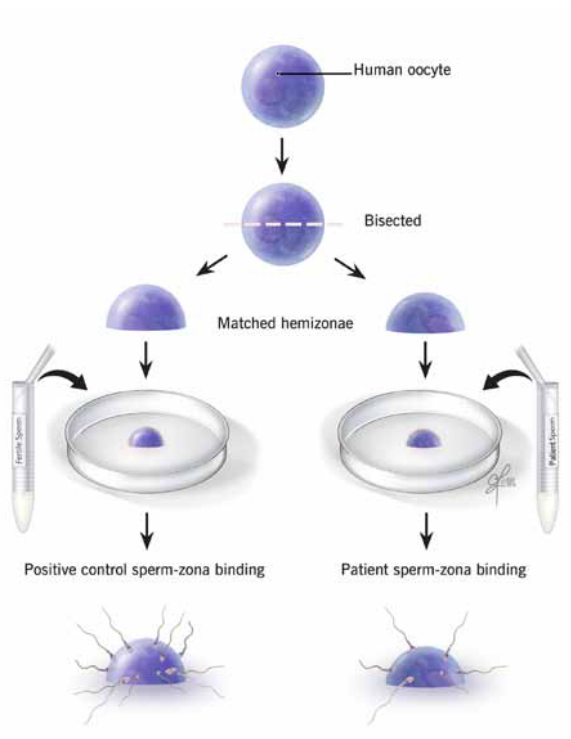
Figure 3 - Hemizona assay. The zona pellucida is isolated and divided in half. One half is incubated with fertile donor sperm (positive control) and the other half is incubated with patient sperm. The ratio of fertile to donor binding is